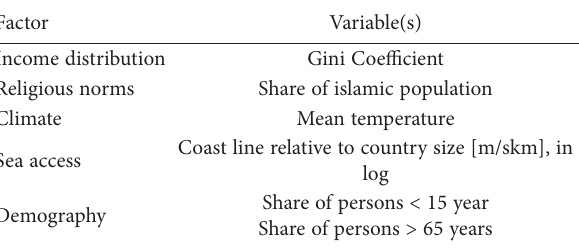
Table 4. Additional factors